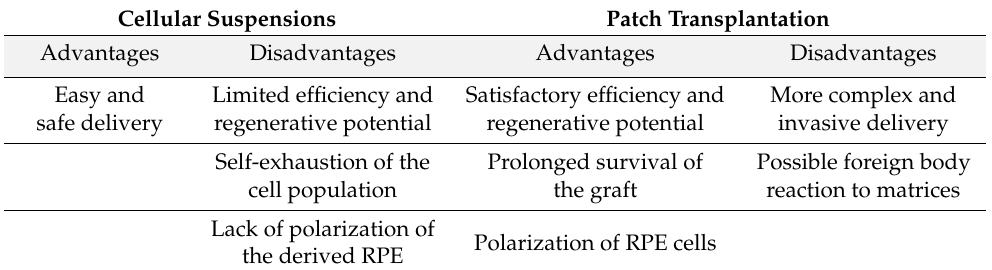
Table 3. Advantages and disadvantages of cellular suspensions and patch